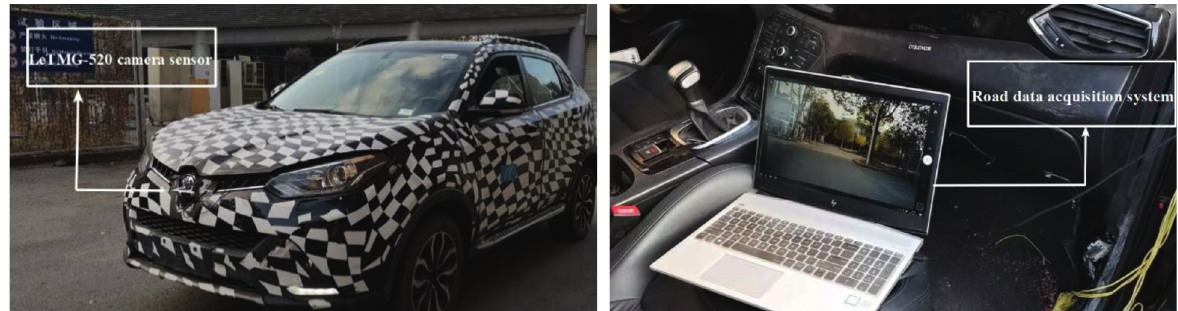
Figure 6: Camera installation and data